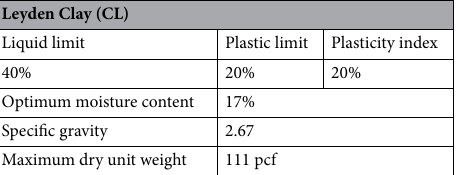
Table 2. Specific gravity, Atterberg limits, and standard proctor values for Leyden Clay.